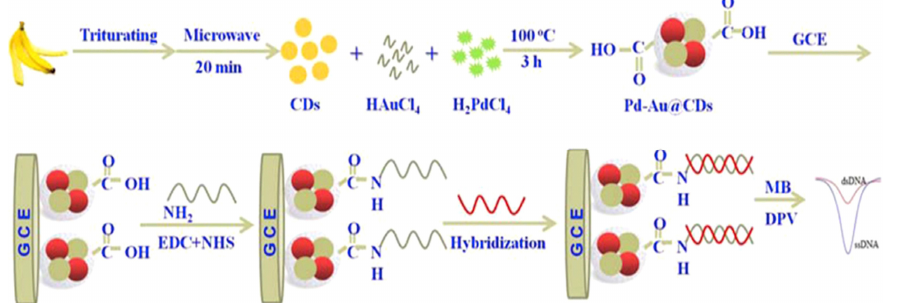
Figure 13. Schematic showing of the synthesis of carbon dots (CDs), their decoration with Pd and Au, and the construction of DNA sensor for colitoxin detection. Adapted with permission from Huang et al. [102] (copyright © (2017), Elsevier).